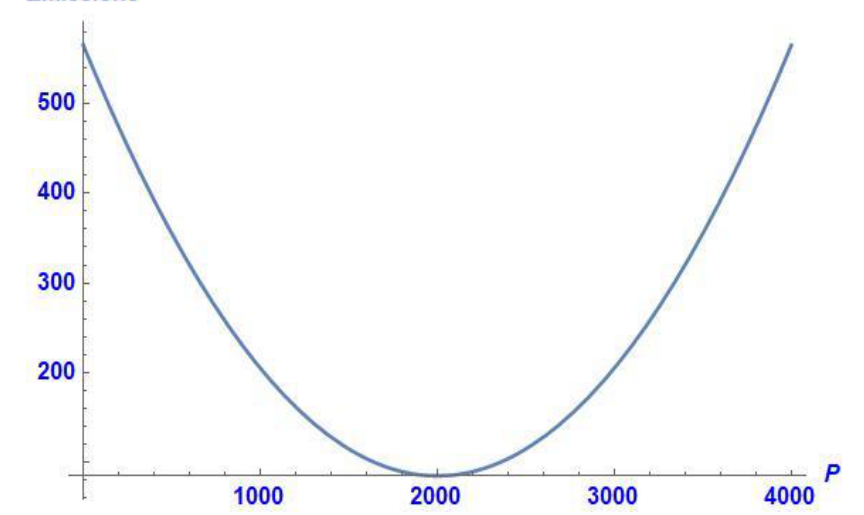
Figure 3. Change in total emission versus the P .